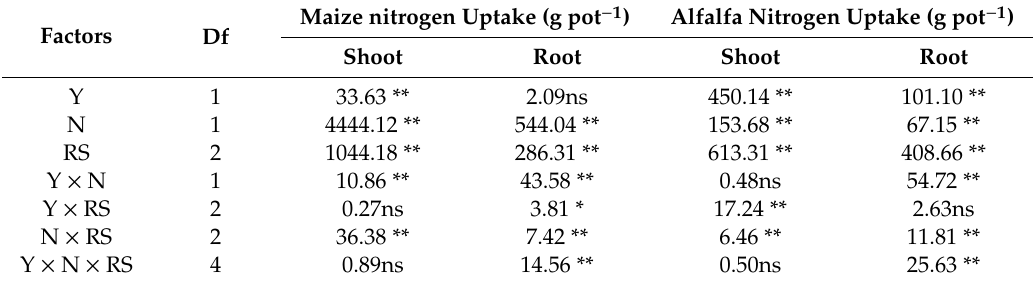
Table 2. Results of repeated measures ANOVA for the nitrogen uptake of maize and alfalfa, with nitrogen level (N) and root separation method (RS) as the independent variables and year (Y) as the repeated measure.